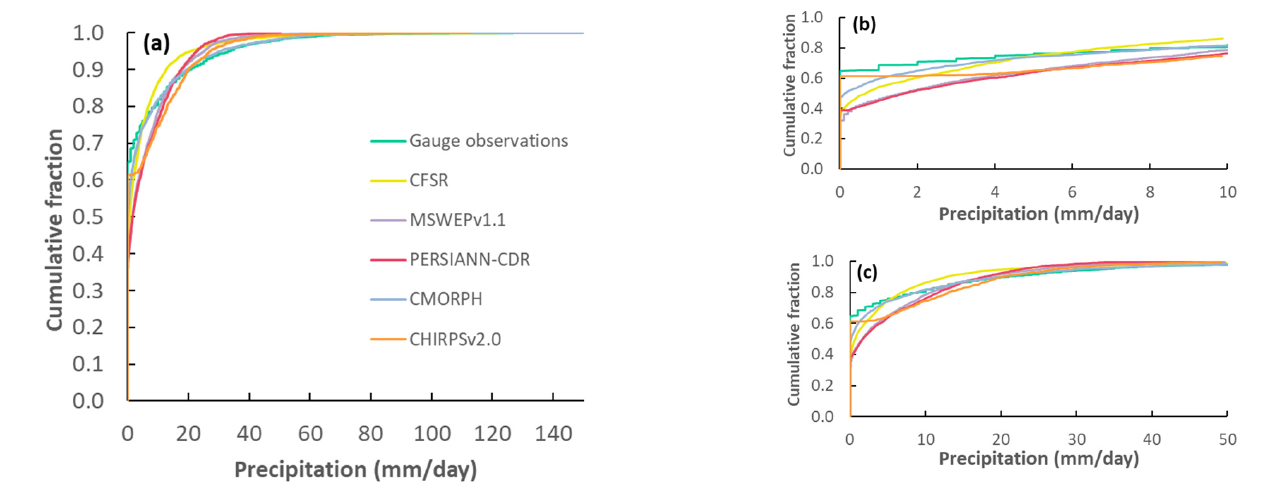
Figure 5. Distribution of daily precipitation values of the six precipitation inputs at PS-1: ( a ) distribution of all precipitation values; ( b ) distribution of precipitation < 10 mm; ( c ) distribution of 10 mm ≤ precipitation ≤ 50 mm.